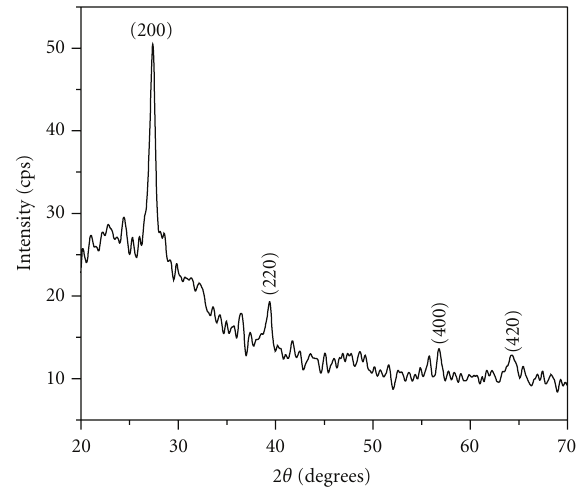
Figure 1: X-ray di ff ractogram of PbTe thin film.